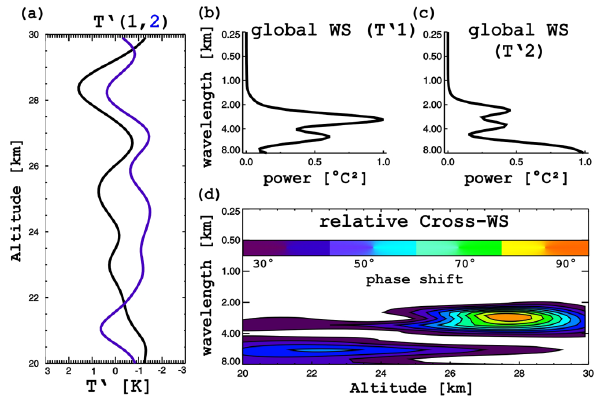
Fig. 2. Displayed are two vertical temperature profiles with a phase shift of 40 ◦ ( a ), the projected and real horizontal wavelet within 3 points of measurement when the corresponding horizontal wave is known ( b ), the 3 points of measurement and the well-known param- eters ( c ) and the three possible derived horizontal wave vectors for those 3 points ( d ). For explanations, see